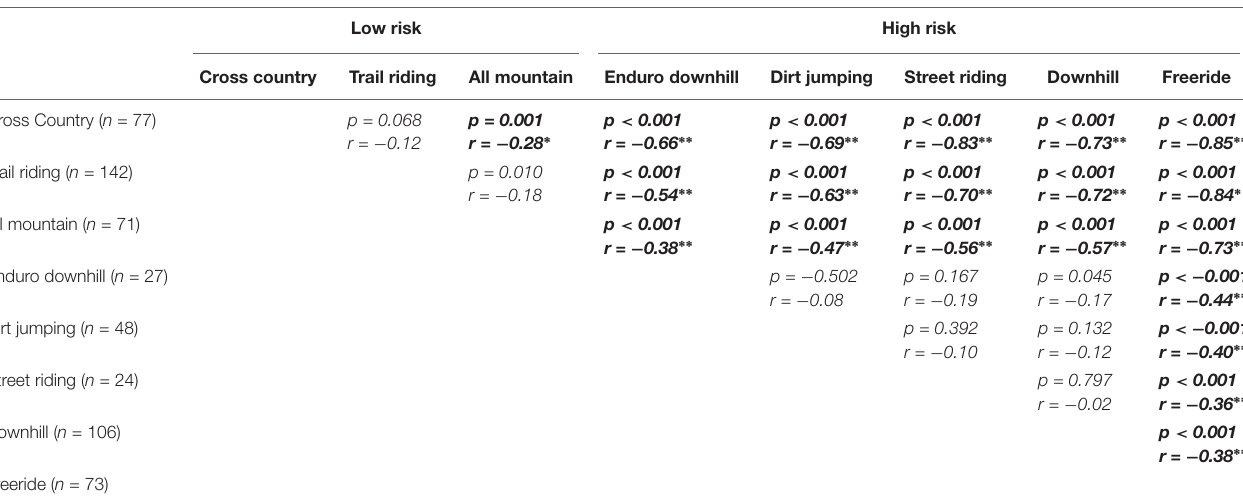
TABLE 4 | Comparative association of risk-taking between riding styles.